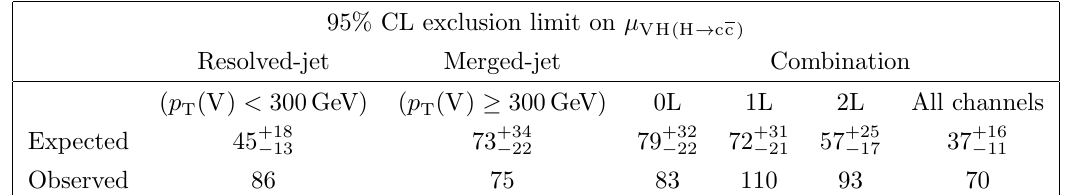
Table 6 . The 95% CL upper limits on the signal strength (cid:22) for the resolved-jet topology analysis for p p (V) (cid:21) 300 GeV, and their combination. T